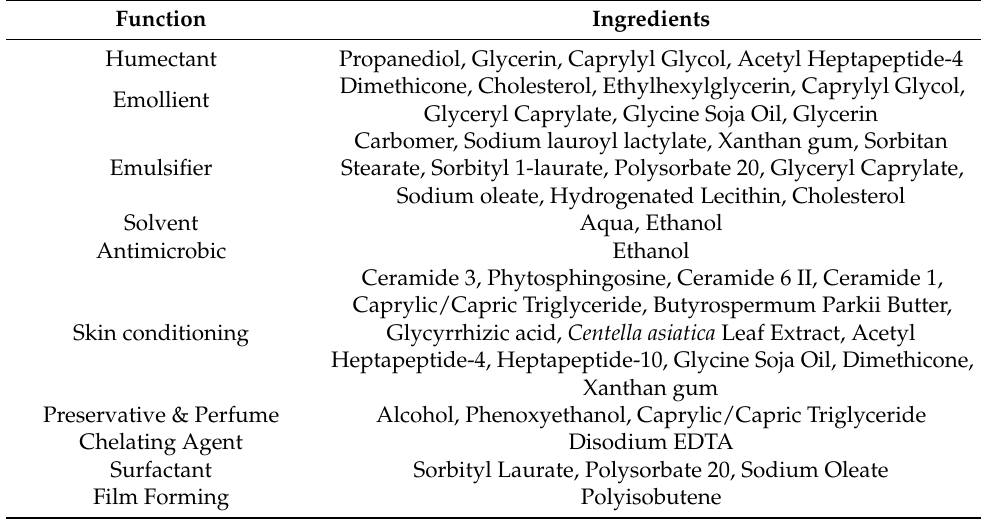
Table 1. Functional classification of ingredients contained in the cream used in the study. Function